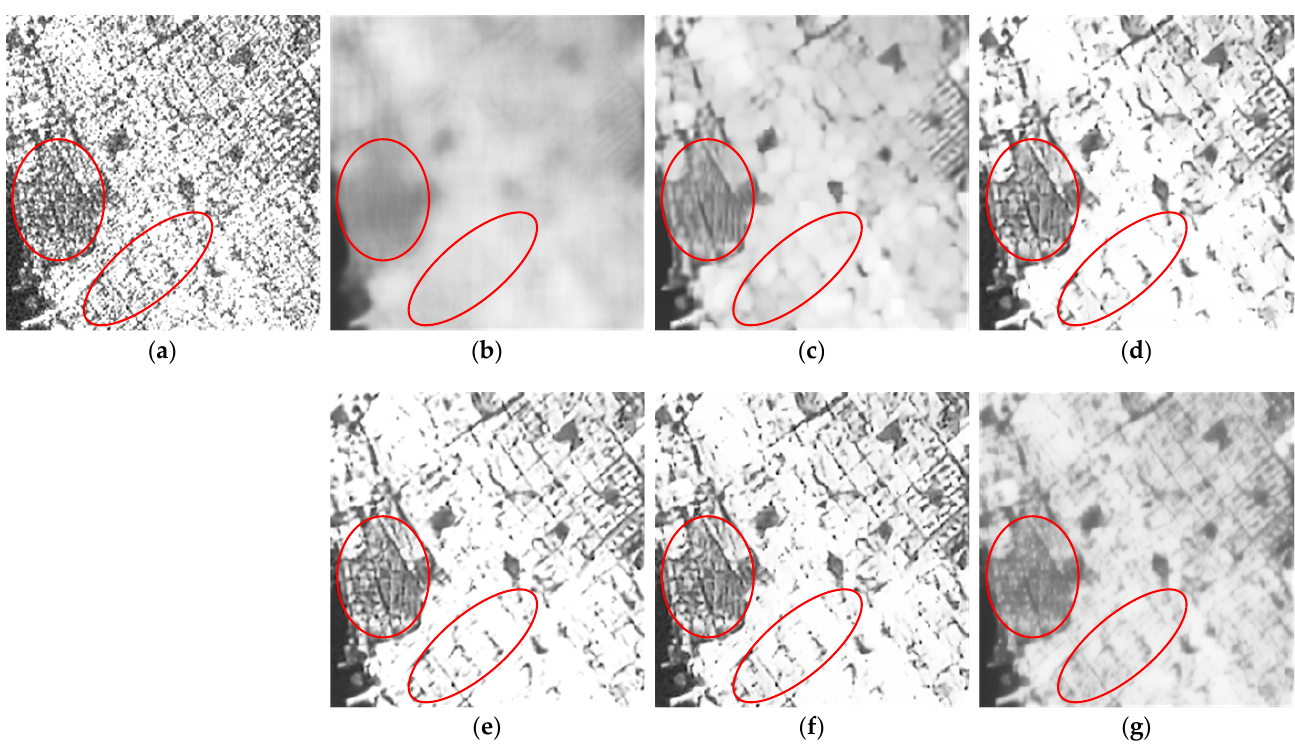
Figure 11. Magnified despeckling results for the Sentinel-1 #1 image. ( a ) Speckled. ( b ) PPB. ( c ) SAR-BM3D. ( d ) ID-CNN.